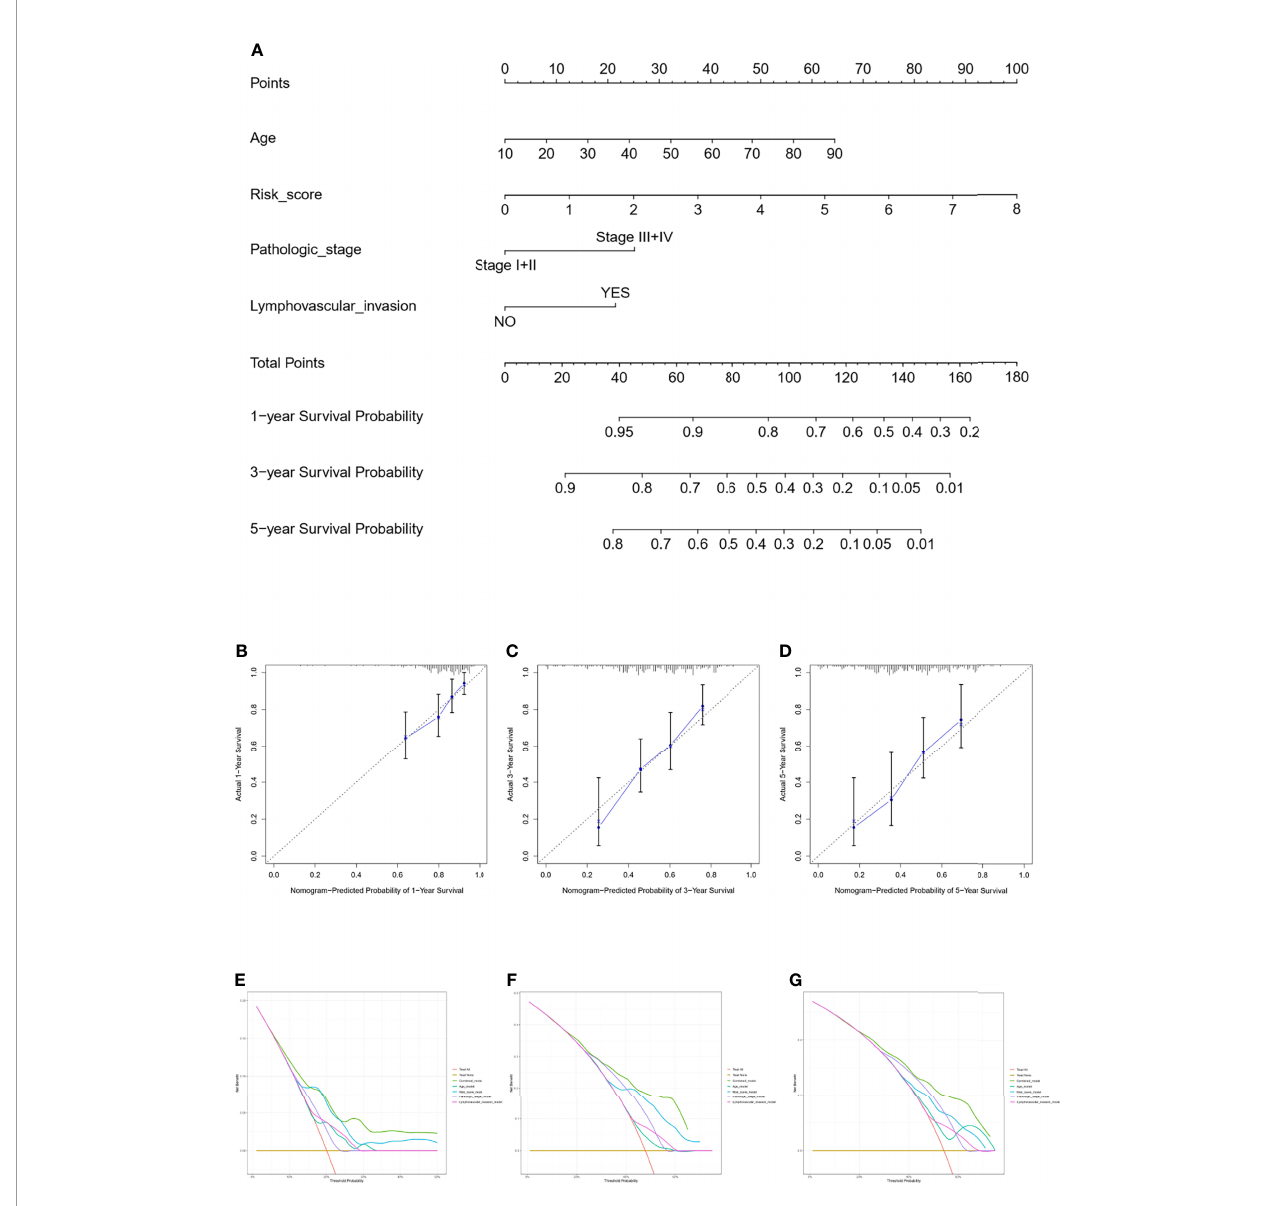
FIGURE 5 | Nomogram for predicting the survival probability of OSCC patients in the TCGA cohort. The nomogram for prediction of the 1-, 3-, and 5-year survival probability for OSCC patients (A) . The calibration curve for prediction of the 1-year (B) , 3-year (C) , and 5-year (D) survival probability for OSCC patients. The DCA curves of the age, risk score, pathologic stage, lymphovascular invasion, and combined nomogram model compared for 1-year (E) , 3-year (F) , and 5-year (G) OS of